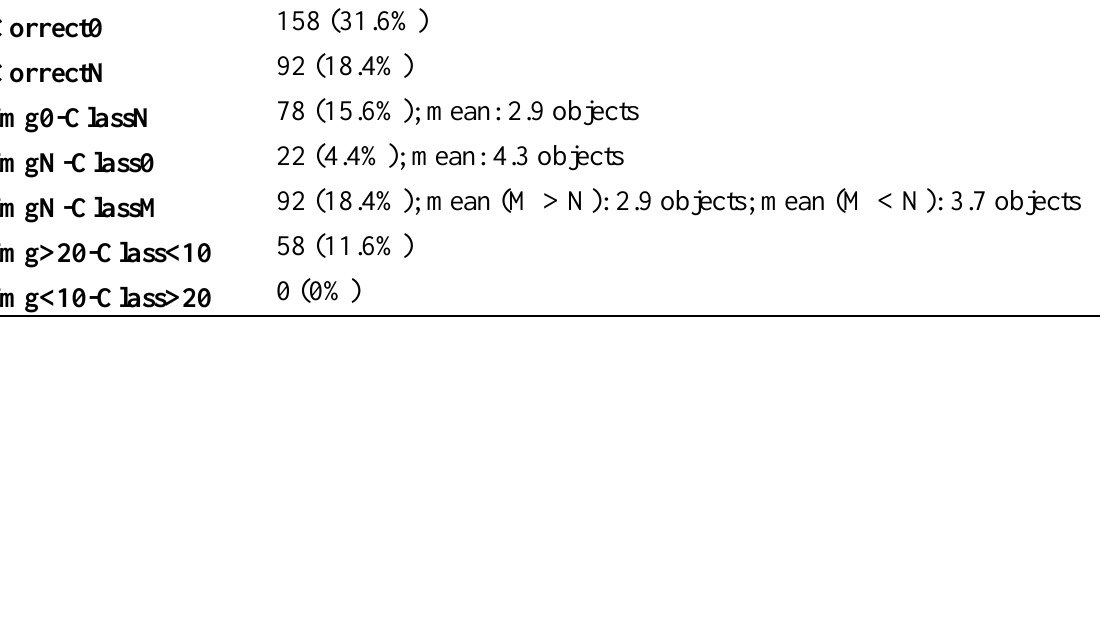
Table 2. Number and percentage of correct (Correct0 and CorrectN) and incorrect fish counts (others) for the automated video image analysis protocol compared to manual counts. Treated images were obtained by the video camera installed on the OBSEA seafloor cabled